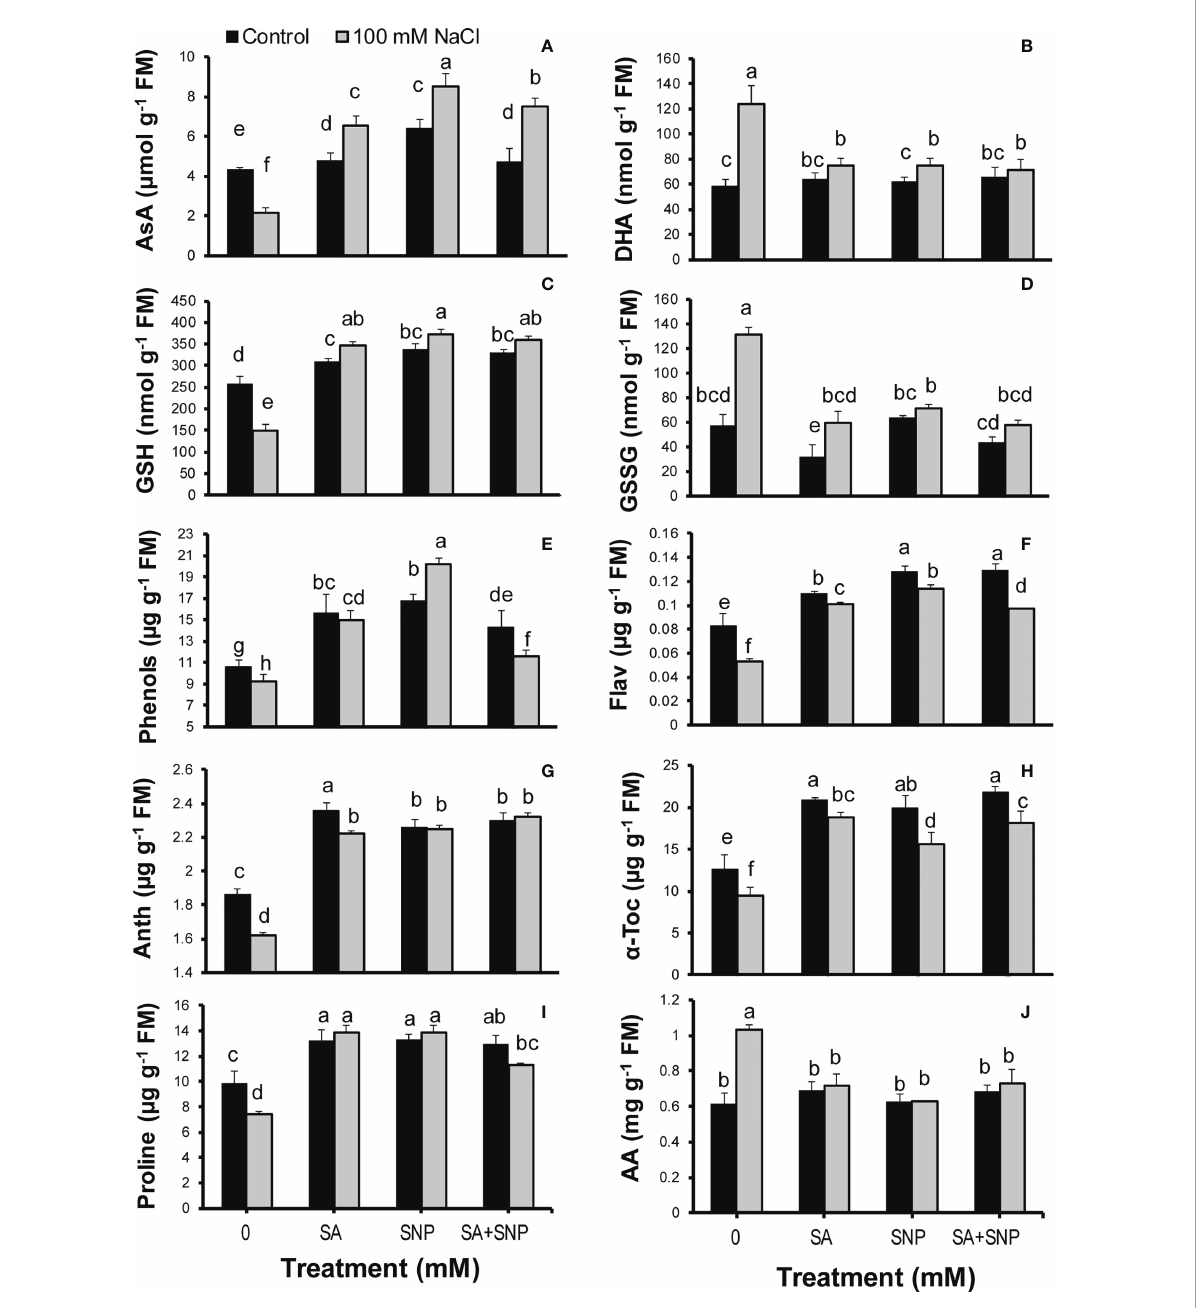
FIGURE 3 (A) Ascorbate (AsA), (B) dehydroascorbate (DHA), (C) reduced glutathione (GSH), (D) oxidized glutathione (GSSG), (E) phenols, (F) fl avonoids(Flav), (G) anthocyanins (Anth), (H) a -tocopherol ( a -Toc), (I) proline, and (J) total free amino acids (AA) in Chenopodium quinoa underdifferent treatments of salicylic acid (SA)and sodium nitroprusside (SNP), and salinity stress. Columns with different letters aresigni fi cantly different at p <